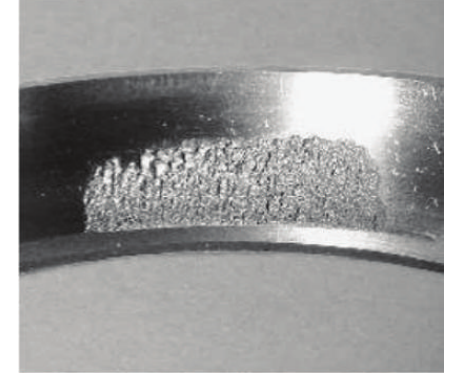
Figure 6: Outer race damage of bearing 1 [27].